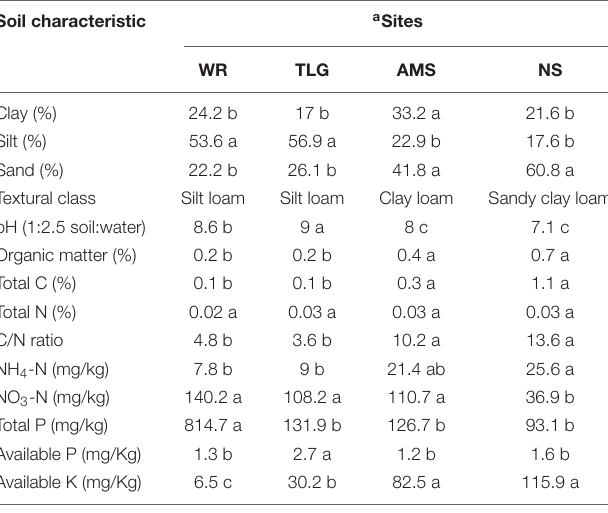
TABLE 1 | Average physicochemical properties of soils at mine sites.